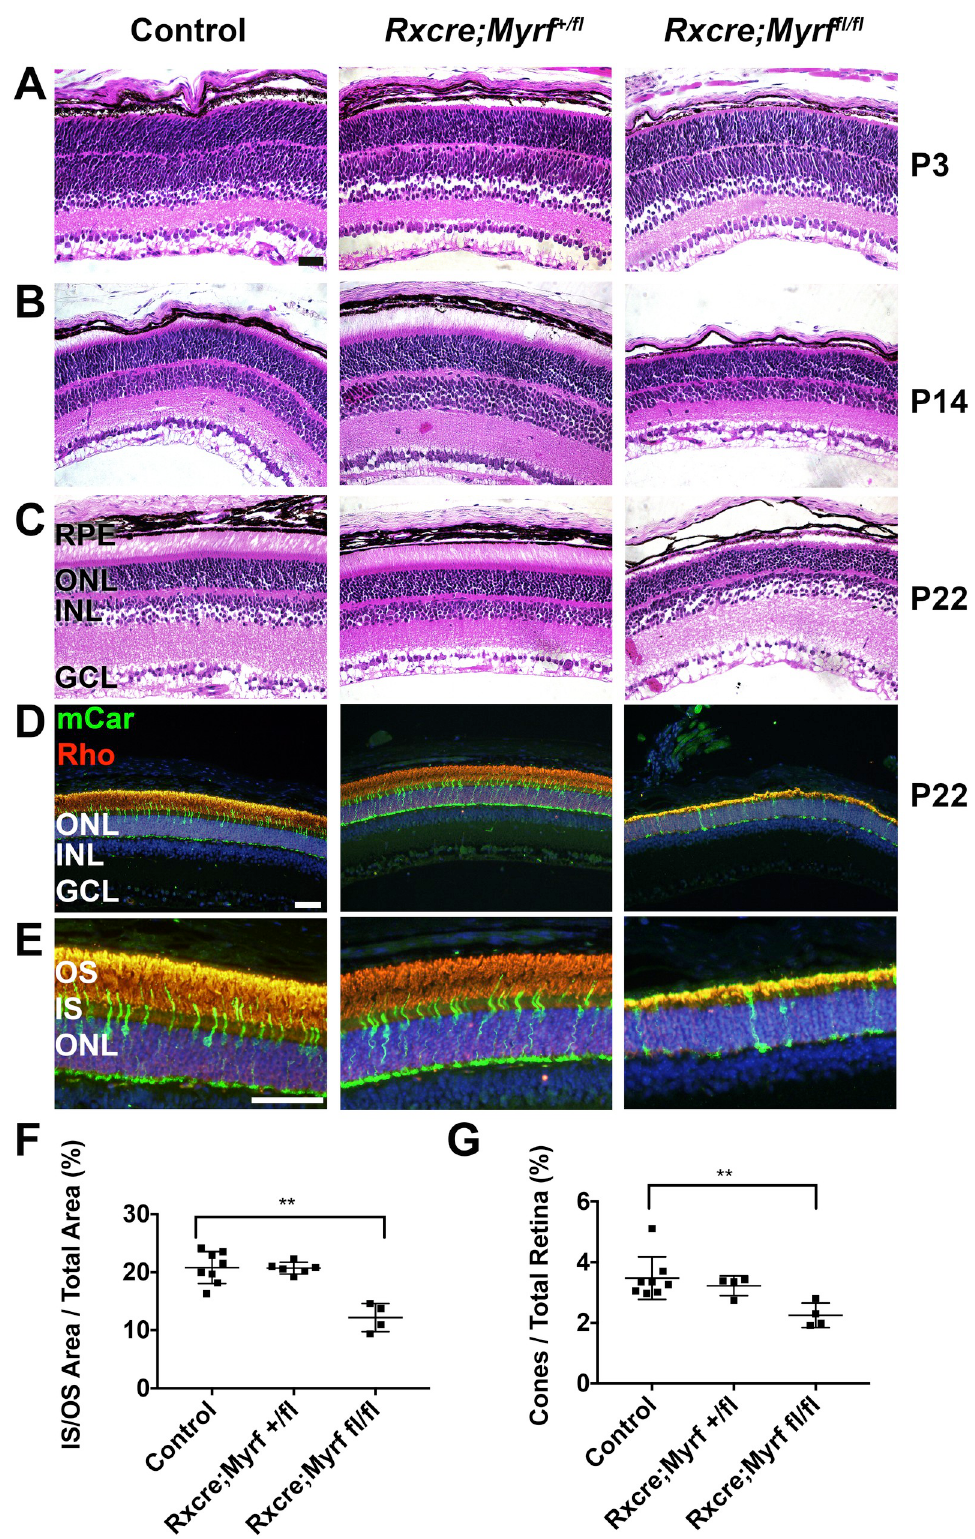
Fig 6. Loss of MYRF leads to early retinal degeneration in mice. (A-C) H&E histology of P3 (A), P14 (B), and P22 (C) control ( Myrf +/fl or Myrf fl/fl ) or Myrf heterozygous and homozygous conditional knockout mice ( RxCre;Myrf +/fl